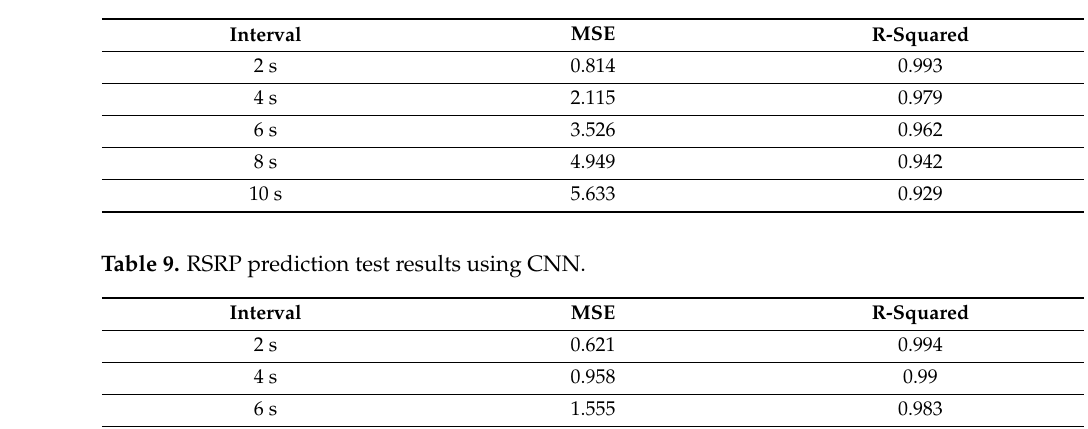
Table 8. RSRP prediction test results using MLP.